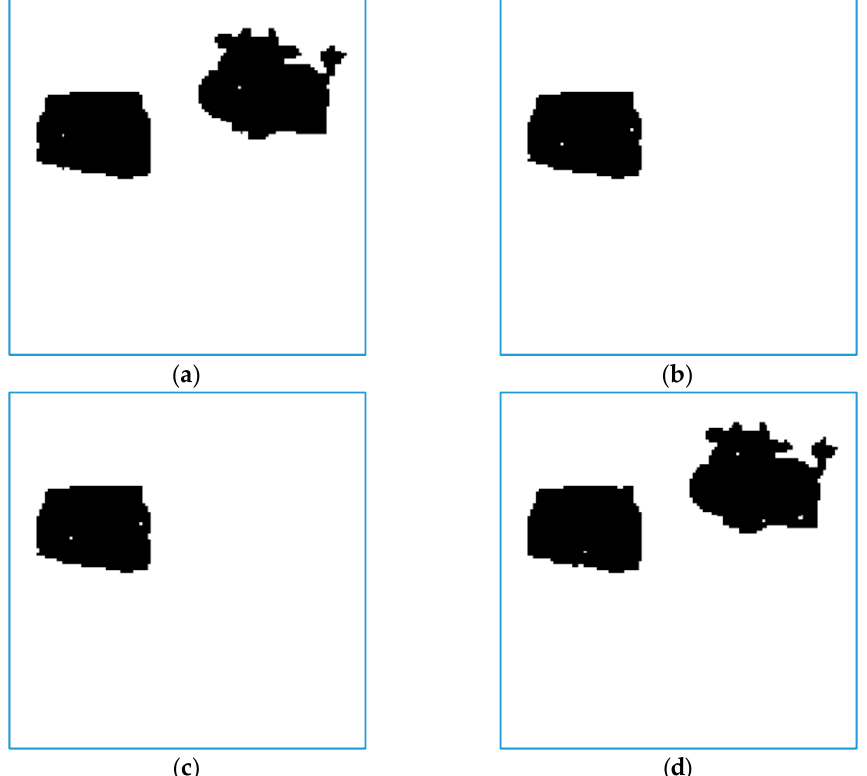
Figure 11. The second stage detection results of different methods. ( a ) Detection result of [17]; ( b ) Detection result of [18]; ( c ) Detection result of [19]; ( d ) Detection result of the proposed method. Table 7. Comparisons with other